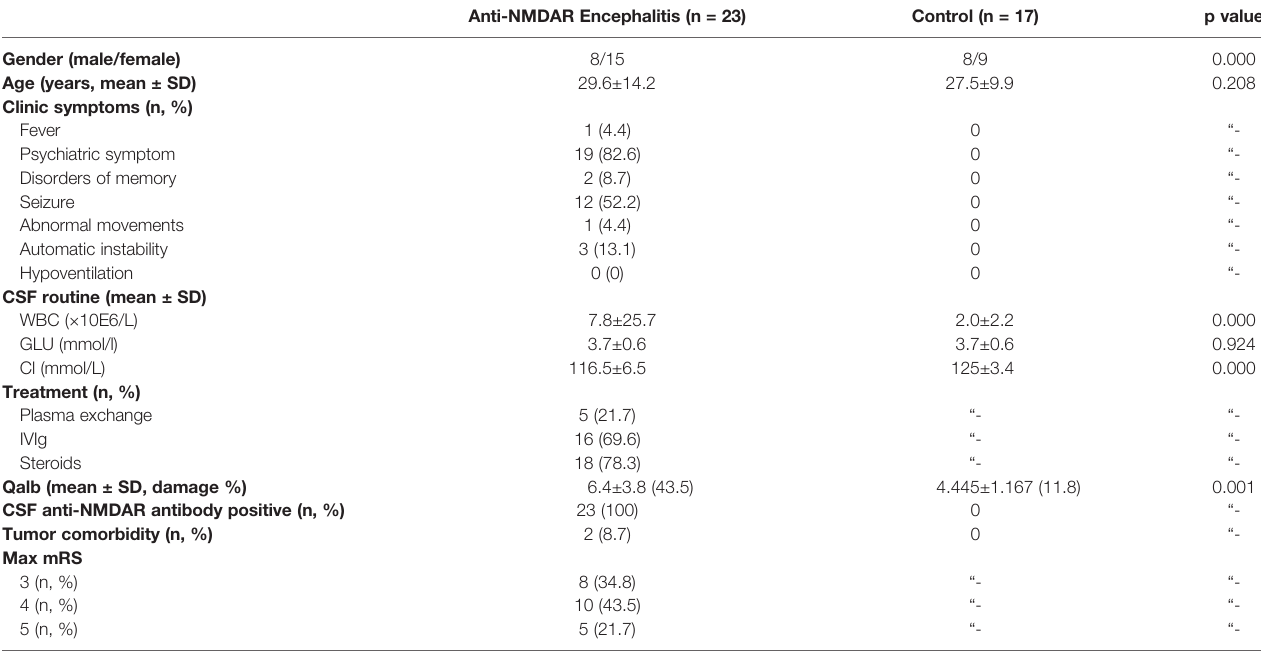
TABLE 1 | Clinic characteristics of anti-NMDAR encephalitis patients and